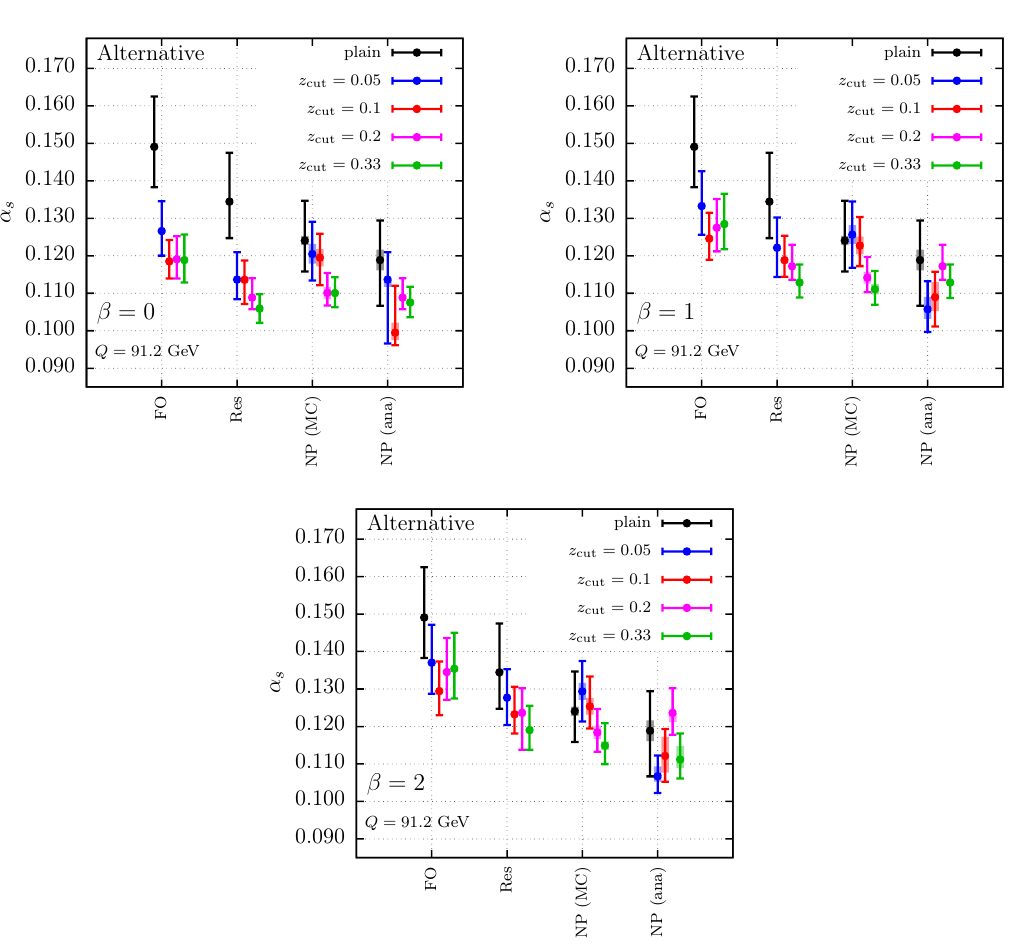
Figure 13. Similar results to (cid:12)gure 6 making use of an alternative resummation code with a di(cid:11)erent treatment for the resummation